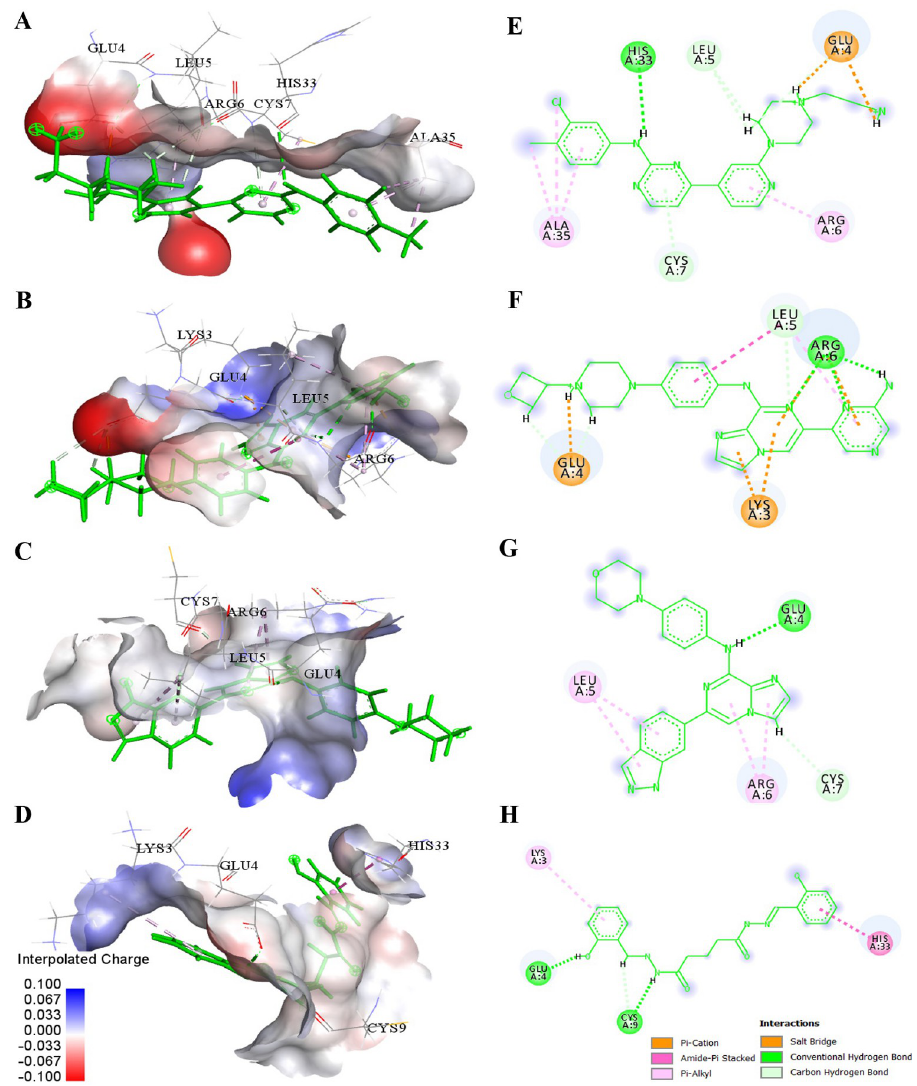
Fig 9. Schematic representations (3D and 2D) of the binding interactions between the IL-8 active site and (A & E) DB14770, (B & F) DB12121, (C & G) DB03916, (D & H) NCI106112 at 100 ns of the MD